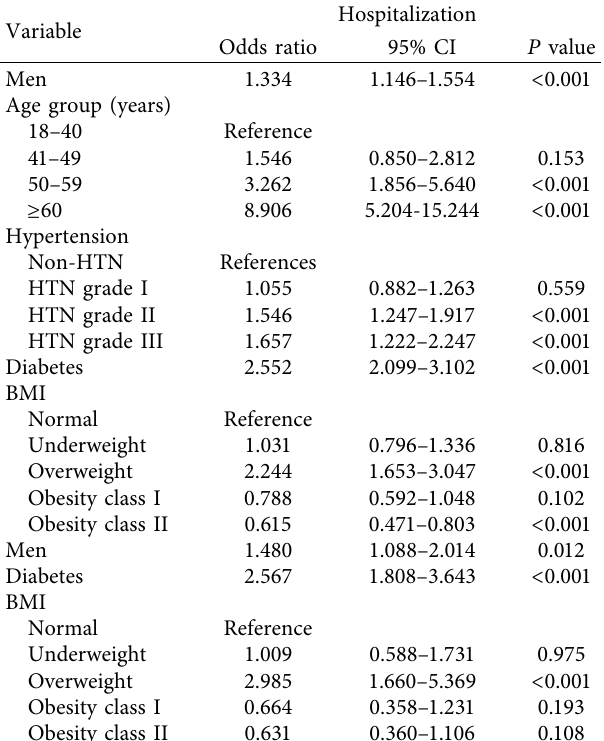
Figure 2: Te cumulative total of classical cardiovascular risk factors with the incidence of hospitalization and mortality (in 1000 individuals). Table 3: Multivariate analysis using logistic regression for risk factors of hospitalization and mortality Hajj pilgrims from East Java, Indonesia, from 2017 to